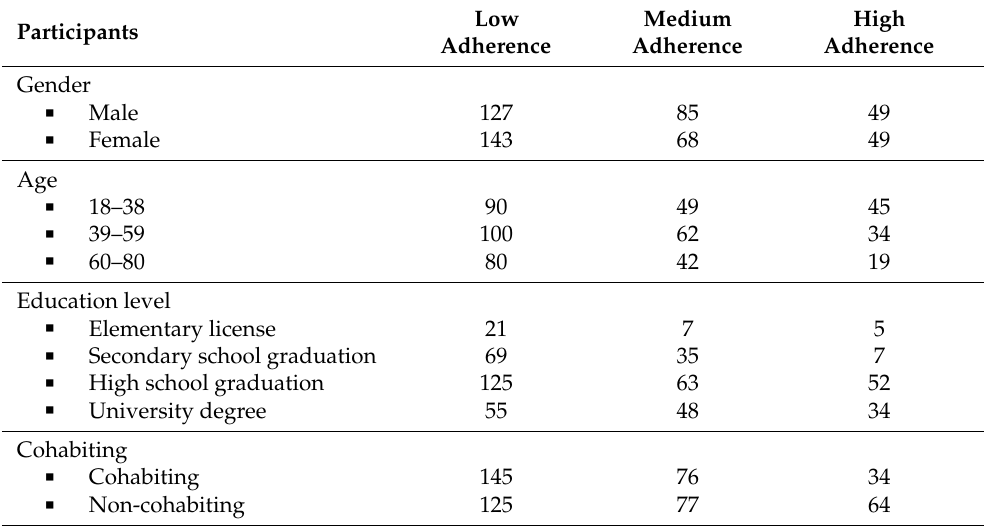
Figure 1. Distribution of the Morisky scale score based on the questions and answers. The overall level of adherence resulted as low in 270 (51.82%) subjects, medium in 153 (29.37%), and high in 98 (18.81%), respectively (Figure 2). 0